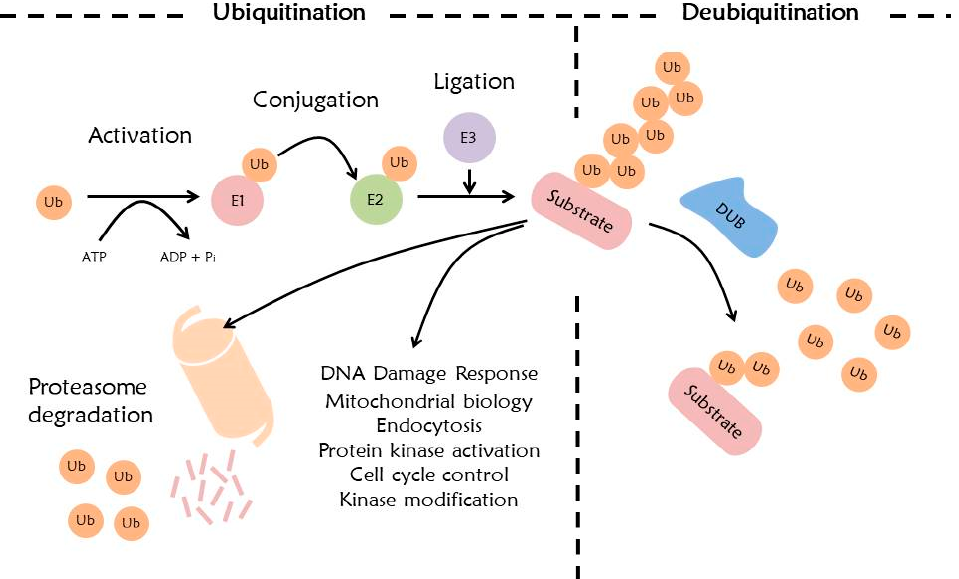
Figure 2. Ubiquitination and deubiquitination system. Ubiquitination proceeds in three steps: activation, conjugation, and ligation through E1, E2, and E3 enzymes. Ubiquitinated substrate is degraded by the 26S proteasome or functions in various other cellular pathways. Deubiquitination is the opposite mechanism of ubiquitination, removing the ubiquitin of the substrate by DUBs.